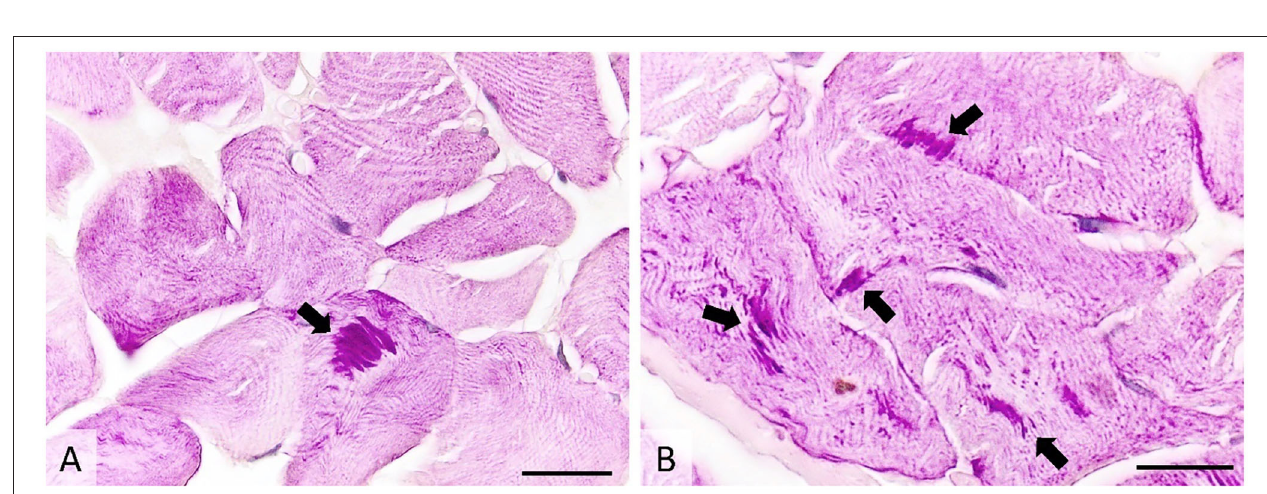
FIGURE 5 | Transverse section of muscle showing many PAS-positive intracytoplasmic inclusions (arrows), occasionally forming subsarcolemmal agglomerations. PAS stain, image (A) -ob × 40 (scale bar = 75 µ m), image (B) -ob × 100 (scale bar = 30 µ m). PAS, periodic